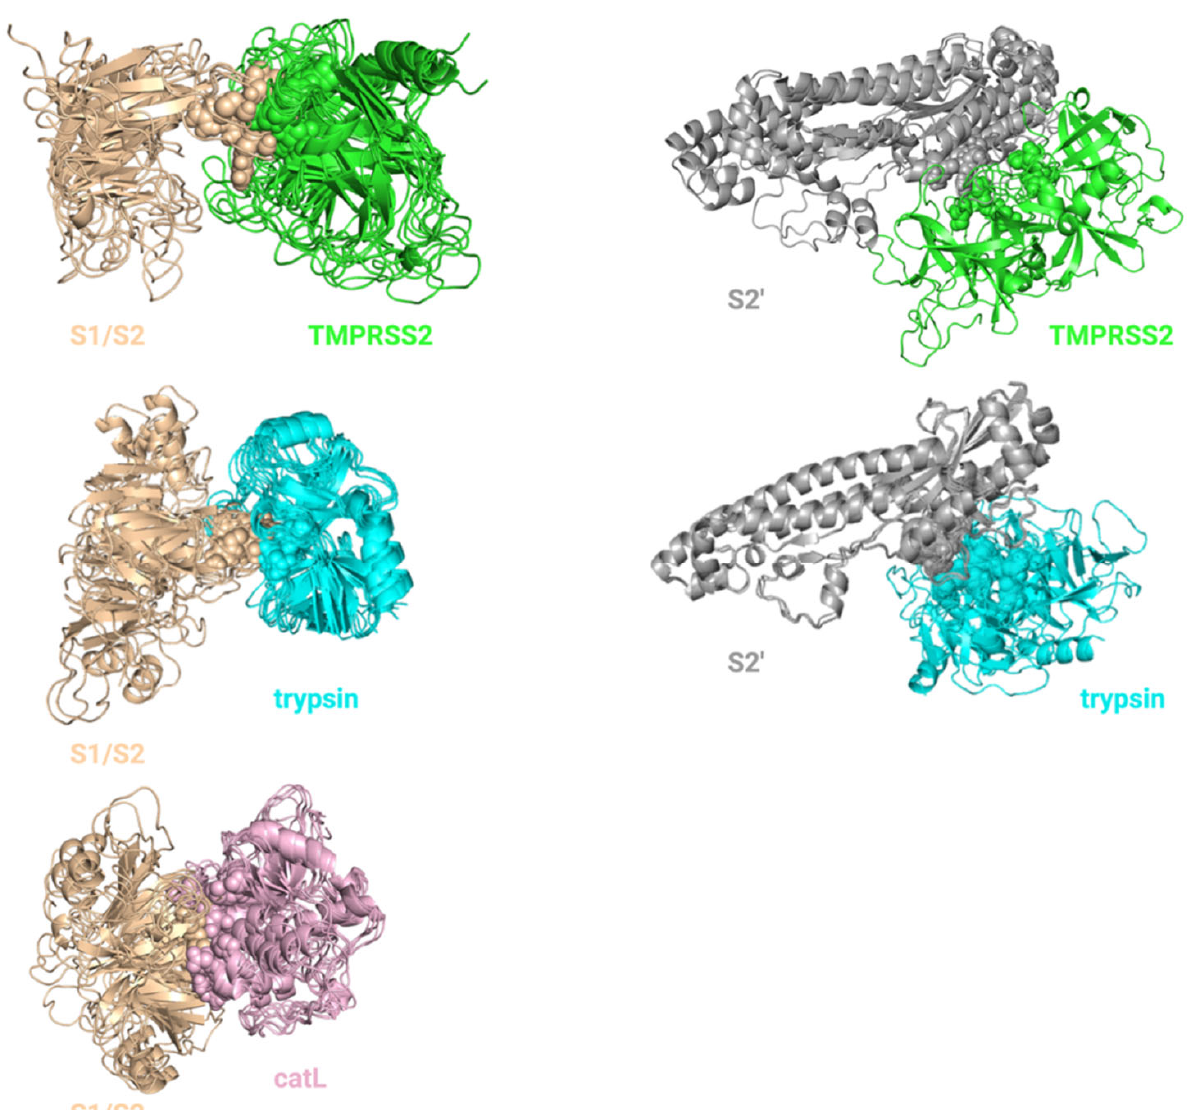
Figure 3. Ensembles of configurations of protease–S protein complexes. Four configurations for TMPRSS2 ‐ S1/S2 complex, two configurations for TMPRSS2 ‐ S2’ complex, six configurations for trypsin ‐ S1/S2 complex, three configurations for trypsin ‐ S2’ complex, six configurations for catL ‐ S1/S2 complex were used for in silico screening. Catalytic sites of the proteases and cleavage sites of the S protein are shown with spheres.